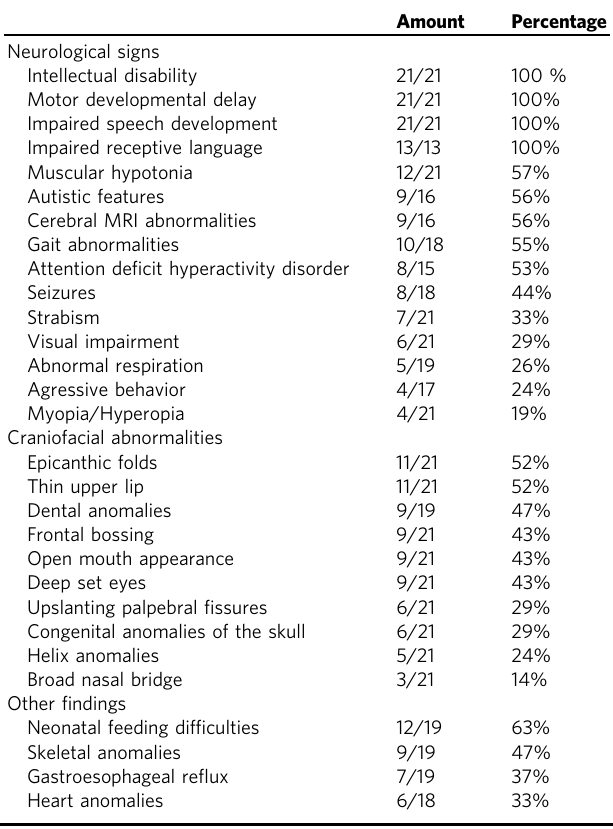
Table 1 Summary of clinical fi ndings in individuals bearing AGO2